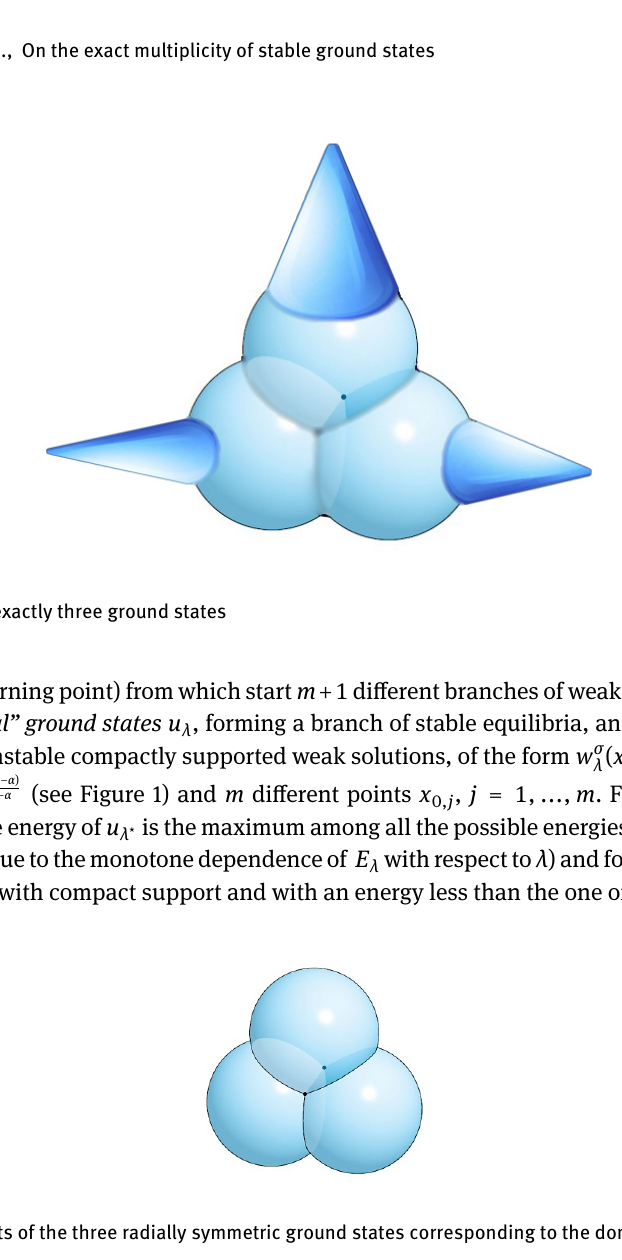
Fig. 2: Union of the supports of the three radially symmetric ground states corresponding to the domain given by Figure